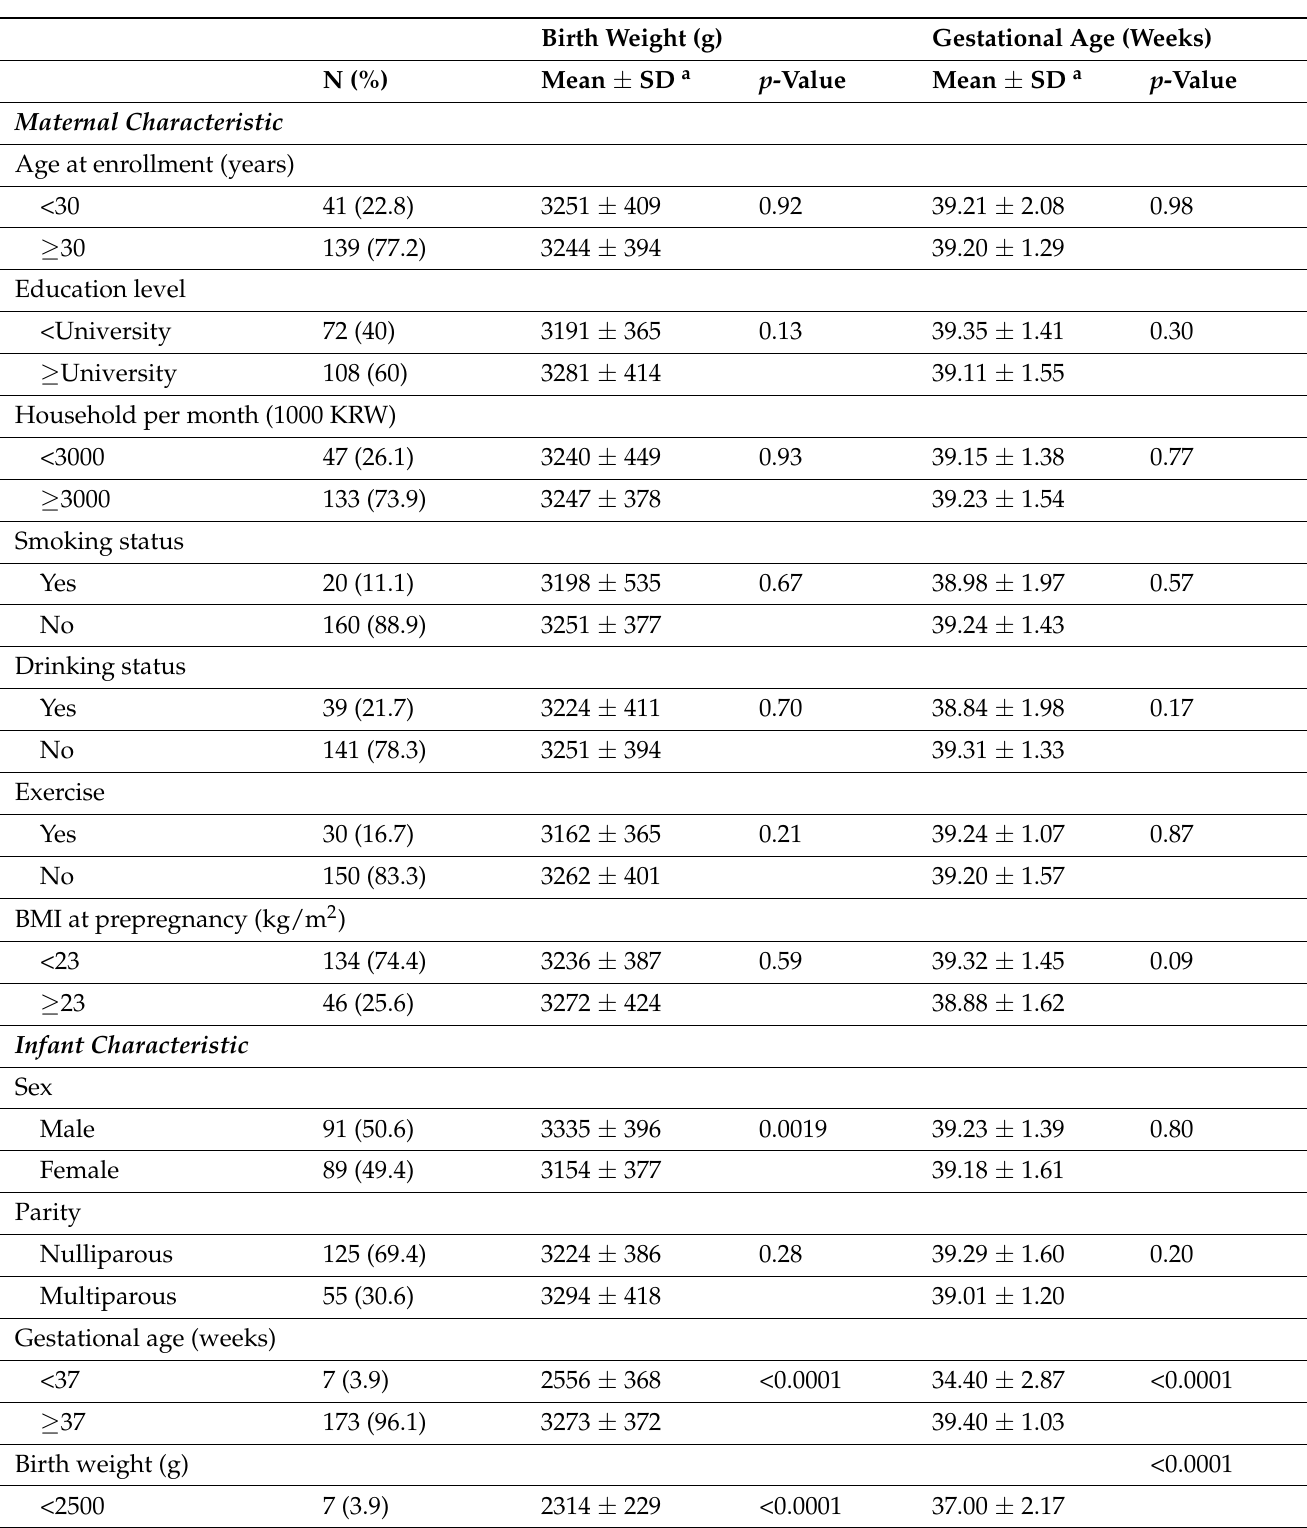
Table 1. Maternal and infant characteristics of the study population ( n =